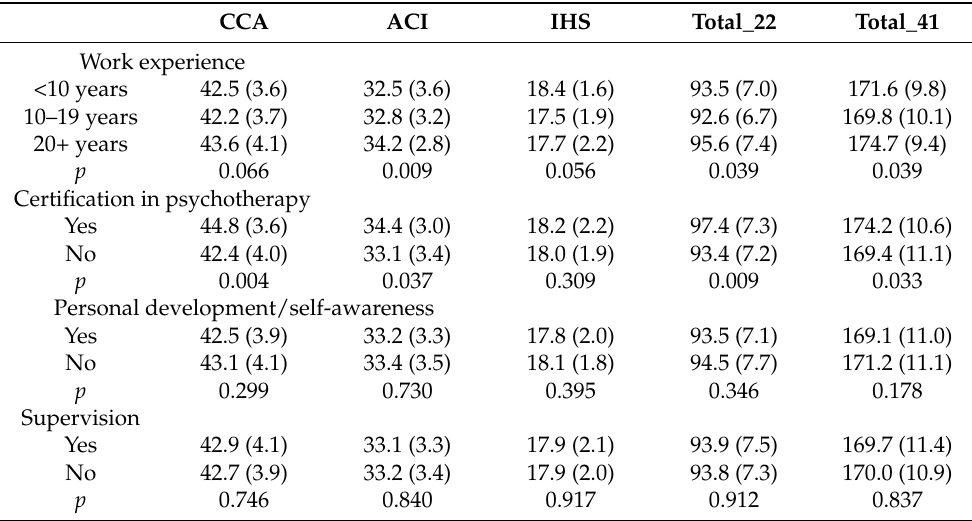
Table 5. Association between work experience and special training with empathy scores.